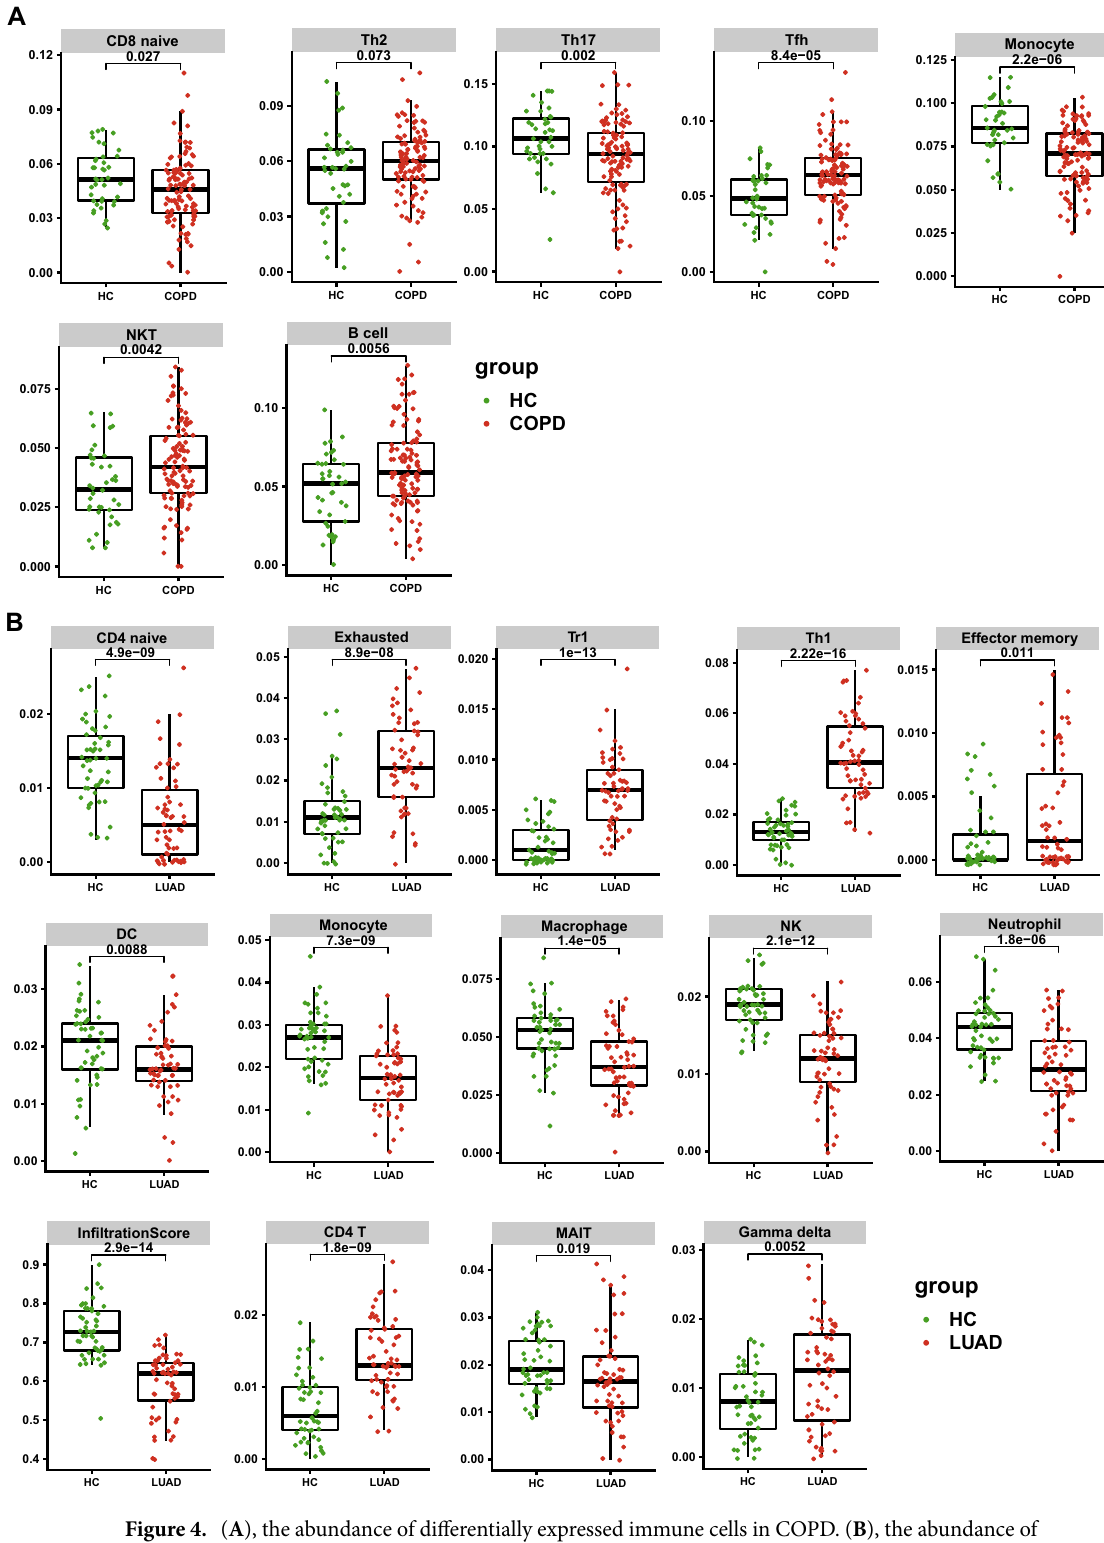
Figure 4. ( A ), the abundance of differentially expressed immune cells in COPD. ( B ), the abundance of differentially expressed immune cells in LUAD. Green represents the control group, and red represents COPD patients. COPD: chronic obstructive pulmonary disease; LUAD: lung adenocarcinoma; HC: control